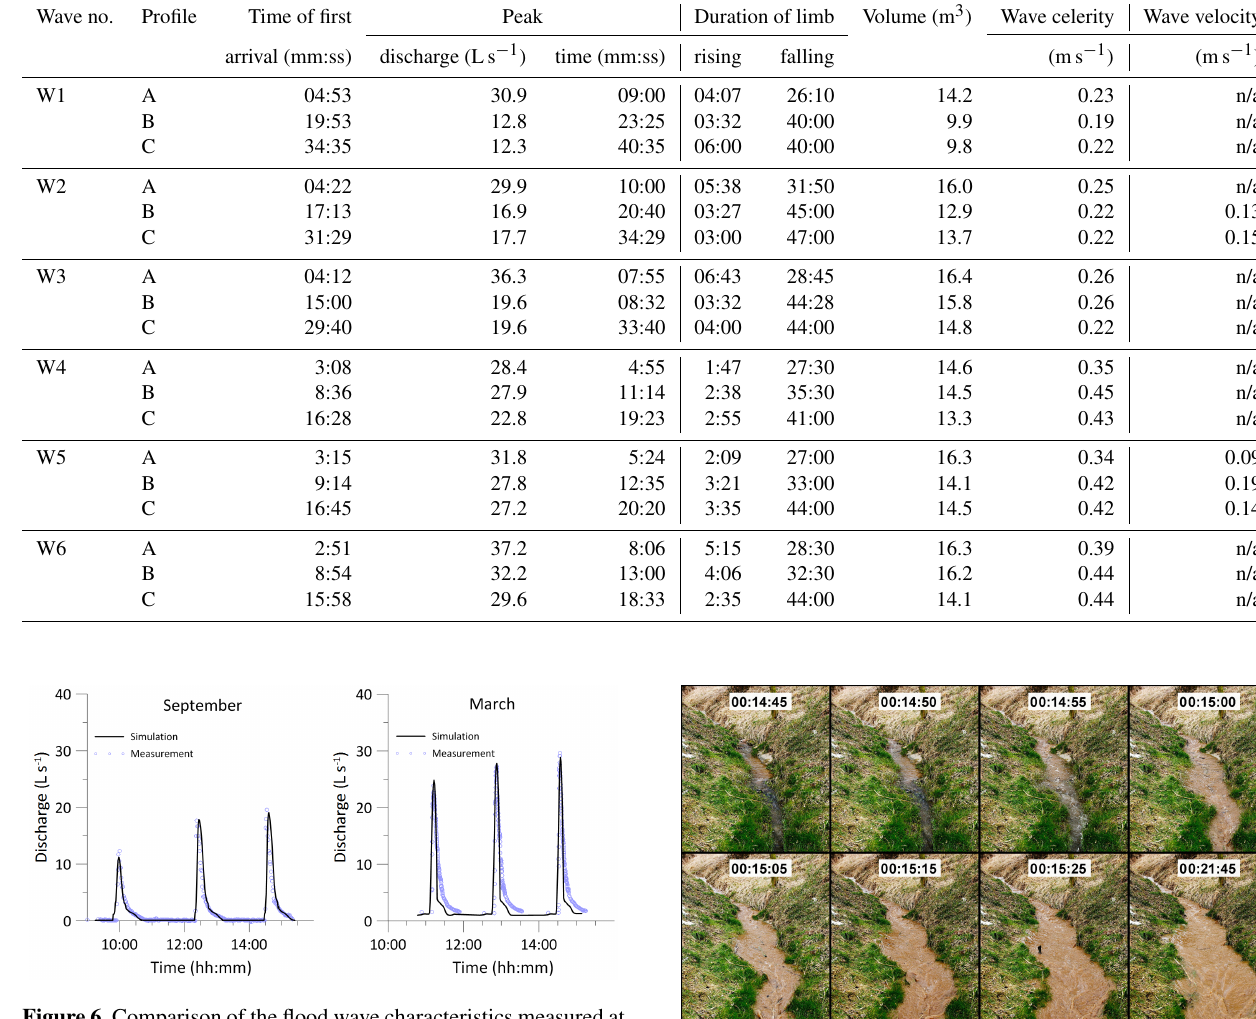
Figure 7. The approach of the W4 wave front at stationing of 400m. The times (hh:mm:ss) stand for the duration from the start of the